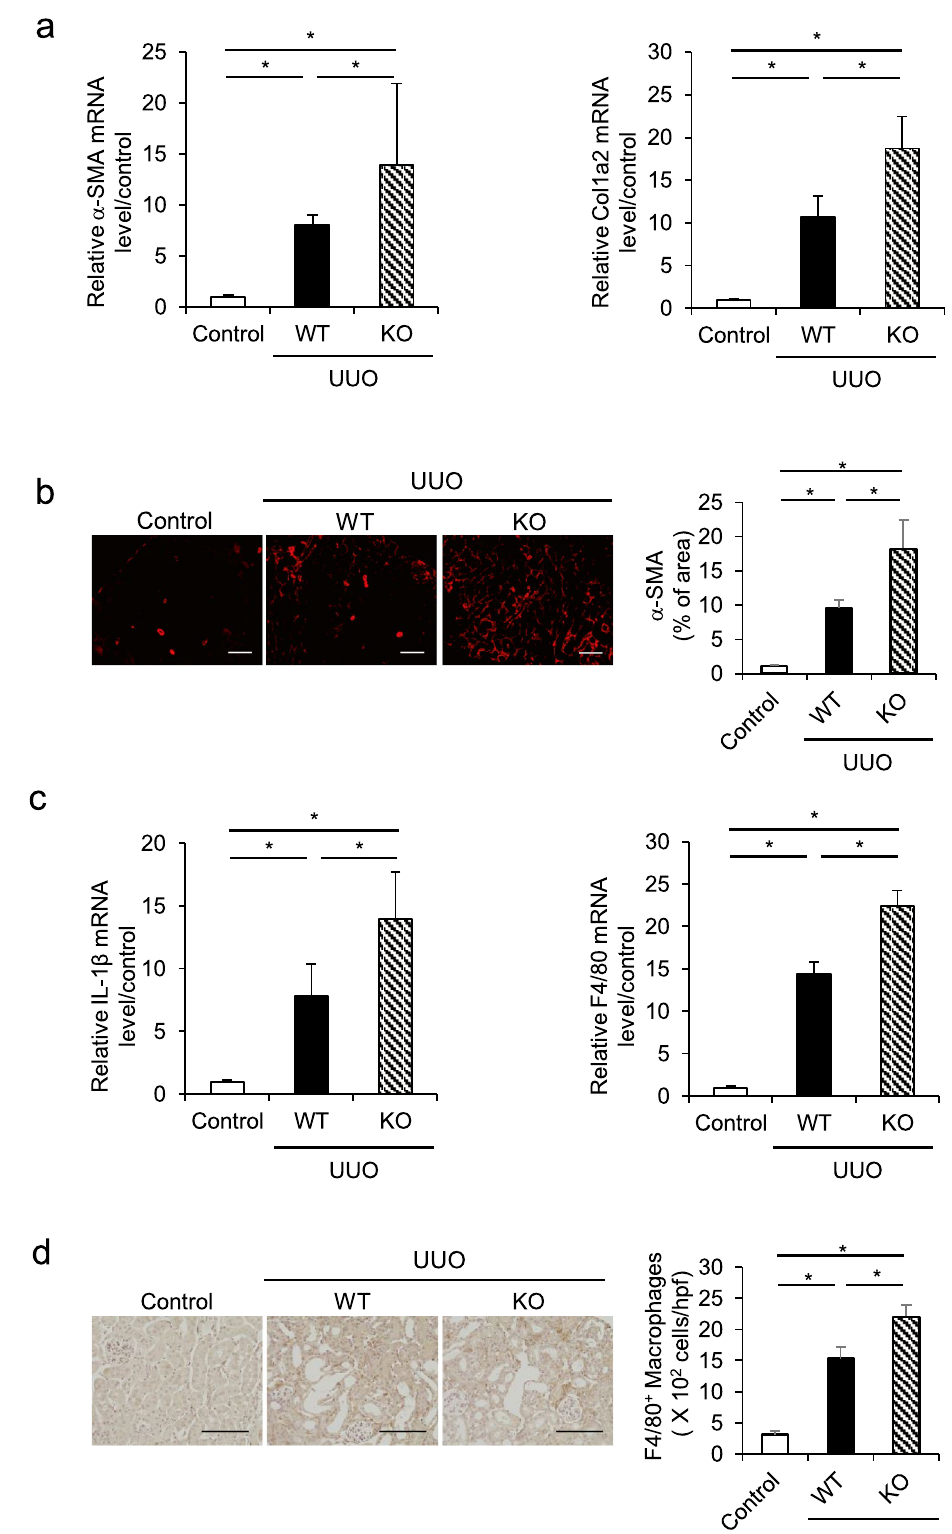
Figure 3. AGP-KO mice showed an exacerbated renal fibrosis and inflammation after the UUO treatment compared with WT mice. ( a ) C57BL/6N WT mice and AGP-KO mice were subjected to UUO treatment. The mRNA expression of α-SMA and Col1a2 was further increased in AGP-KO mice compared with WT mice. ( b ) Immunostaining of α-SMA in kidney was shown. ( c ) mRNA expression of IL-1β and F4/80 was exacerbated in AGP-KO mice compared with WT mice. ( d ) Immunohistochemistry of F4/80 in kidney was shown. *P < 0.05. Data are presented as mean ± SE (n = 4 for control group; n = 9 for each UUO